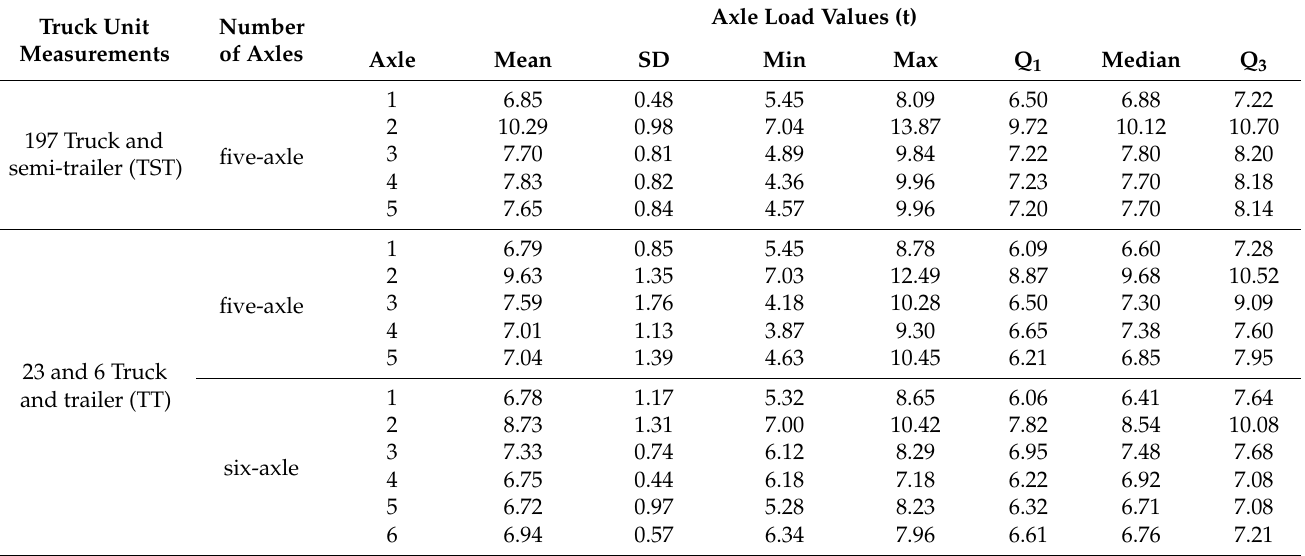
Table 2. Statistical characteristics of the load on individual axles in the transport